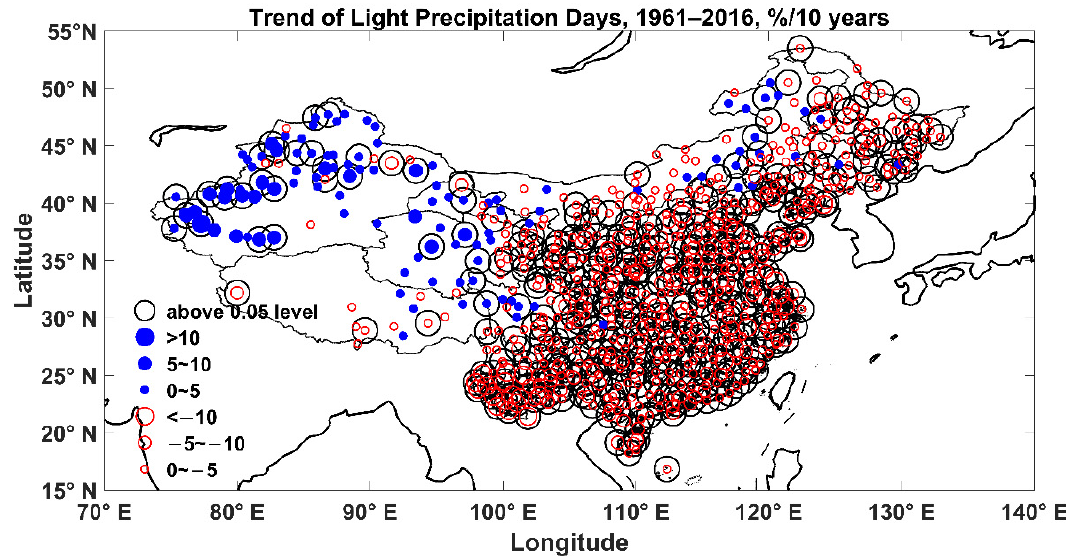
Figure 9. The spatial distributions about the temporal trends of light precipitation occurrence days at 635 ground stations in China.